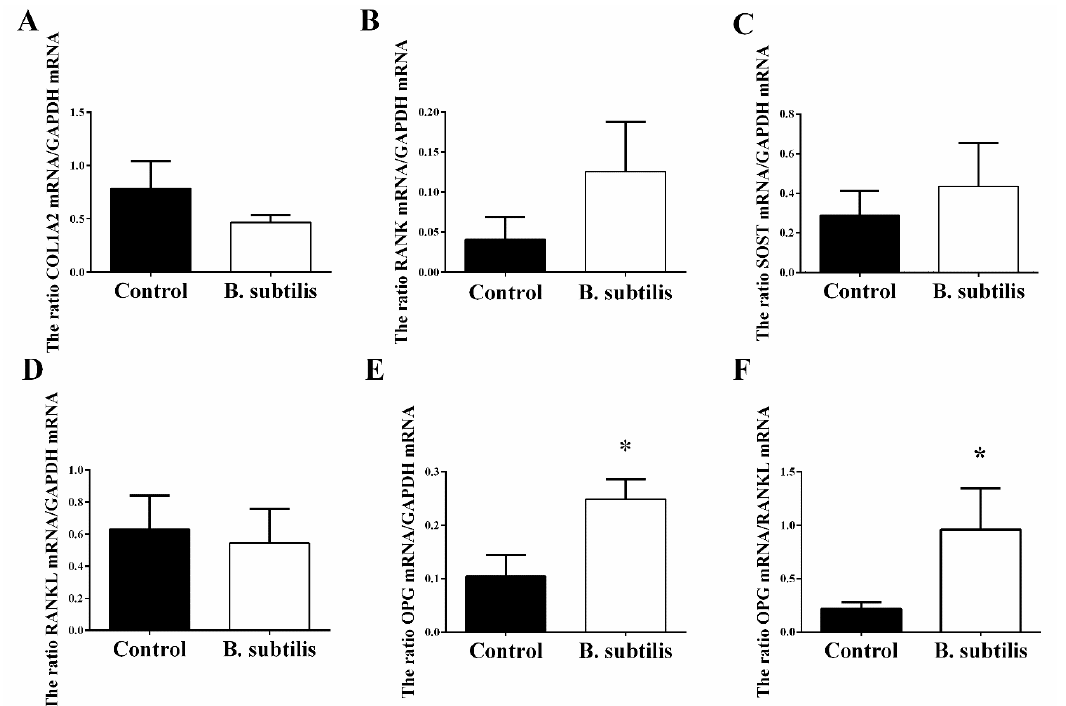
Figure 3. The effects of Bacillus subtilis on bone mRNA expressions in laying hens. ( A ) The change of COL1A2 mRNA expression. ( B ) The change of RANK mRNA expression. ( C ) The change of SOST mRNA expression. ( D ) The change of RANKL mRNA expression. ( E ) The change of OPG mRNA expression. ( F ) The ratio of OPG / RANKL mRNA expression. Data are presented as mean ± SEM ( n = 12 per group) * means p ≤ 0.05. COL1A2 : collagen type I alpha 2 chain; RANK : TNF receptor superfamily member 11a; SOST : sclerostin; RANKL : receptor activator for nuclear factor- κ B ligand; OPG : TNF receptor superfamily member 11b.